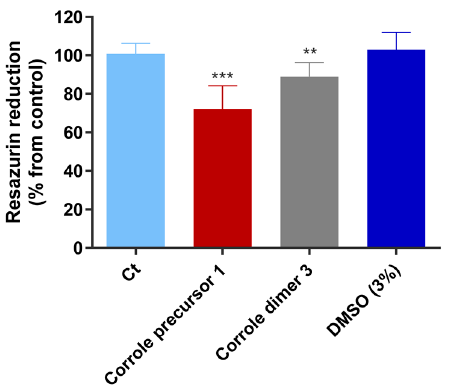
Figure 5. Effect of corrole precursor 1 , dimer 3 , and the solvent DMSO at 3% on the viability of Vero cells. Cytotoxicity profile after 24 h of exposure vs. control cells (Ct). Results are expressed as mean ± SD of three independent experiments performed in triplicate: ** ( p < 0.01), *** ( p < 0.001) compared to Resazurin reduction (%) PSs for control cells (untreated cells).